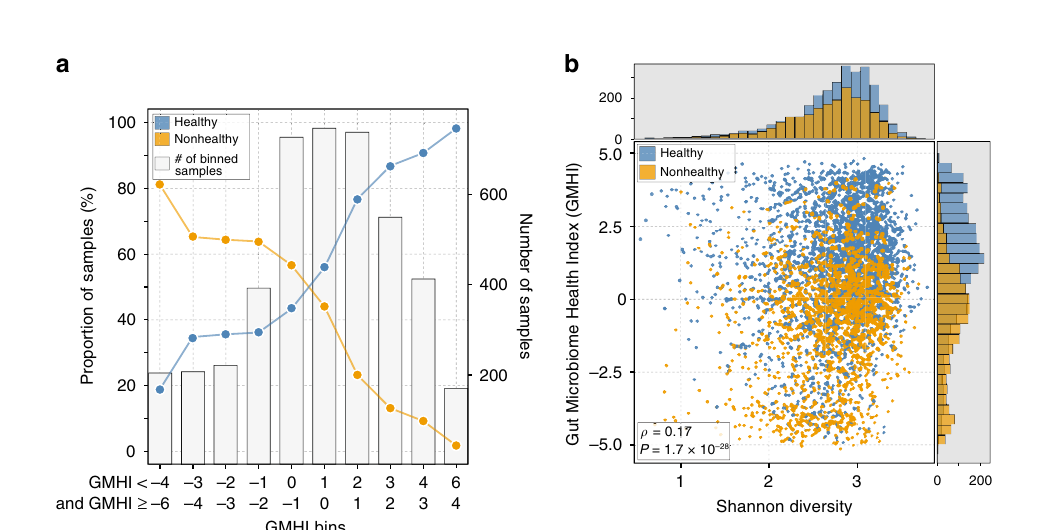
Fig. 4 Changes in group proportions and in Shannon diversity with respect to GMHI. a All 4347 metagenomes were binned according to their GMHI values ( x -axis). Each gray bar indicates the total number of samples in each bin ( y -axis, right). Points indicate proportions (i.e., percentages) of samples in each bin corresponding to either healthy or nonhealthy individuals ( y -axis, left). In bins with a positive range of GMHIs, the majority of samples classi fi ed as healthy; in contrast, samples in bins with a negative range of GMHIs mostly classi fi ed as nonhealthy. This trend was more pronounced towards bins on the far right and left. b GMHI strati fi es healthy ( n = 2636) and nonhealthy ( n = 1711) groups more strongly compared to Shannon diversity. Each point in the scatter-plot corresponds to a metagenome sample (4347 in total). Histograms show the distribution of healthy (blue) and nonhealthy (orange) samples based on the parameter of each axis. In general, GMHI and Shannon diversity demonstrate a weak correlation (Spearman ’ s ρ = 0.17, 95% CI: [0.14, 0.19], P = 1.7 × 10 − 28 ). The P value ( H 0 : ρ = 0) was determined by using a t -distribution with n − 2 degrees of freedom, where n is the total number of